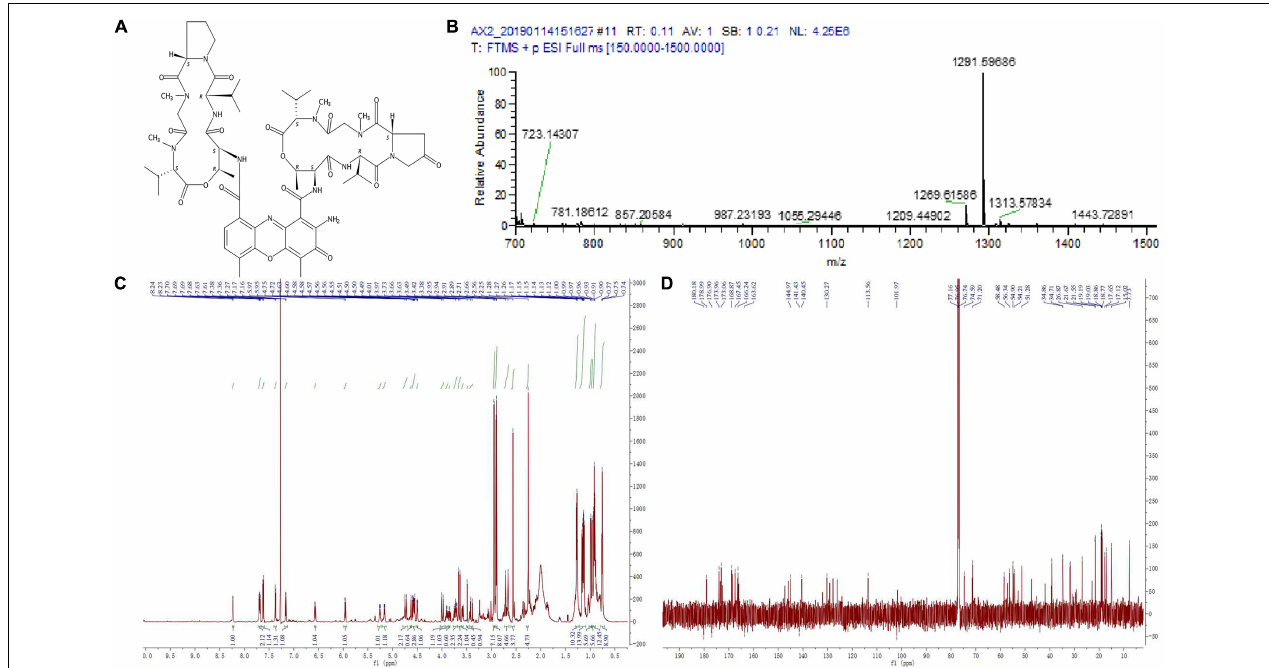
FIGURE 3 | Structure identification of the purified compound 1. (A) Molecular structure of the compound. (B) Mass spectrometry. (C) Proton ( 1 H) nuclear magnetic resonance. (D) Carbon ( 13 C) nuclear magnetic resonance spectrum of the compound 1 in DMOS-6 d .